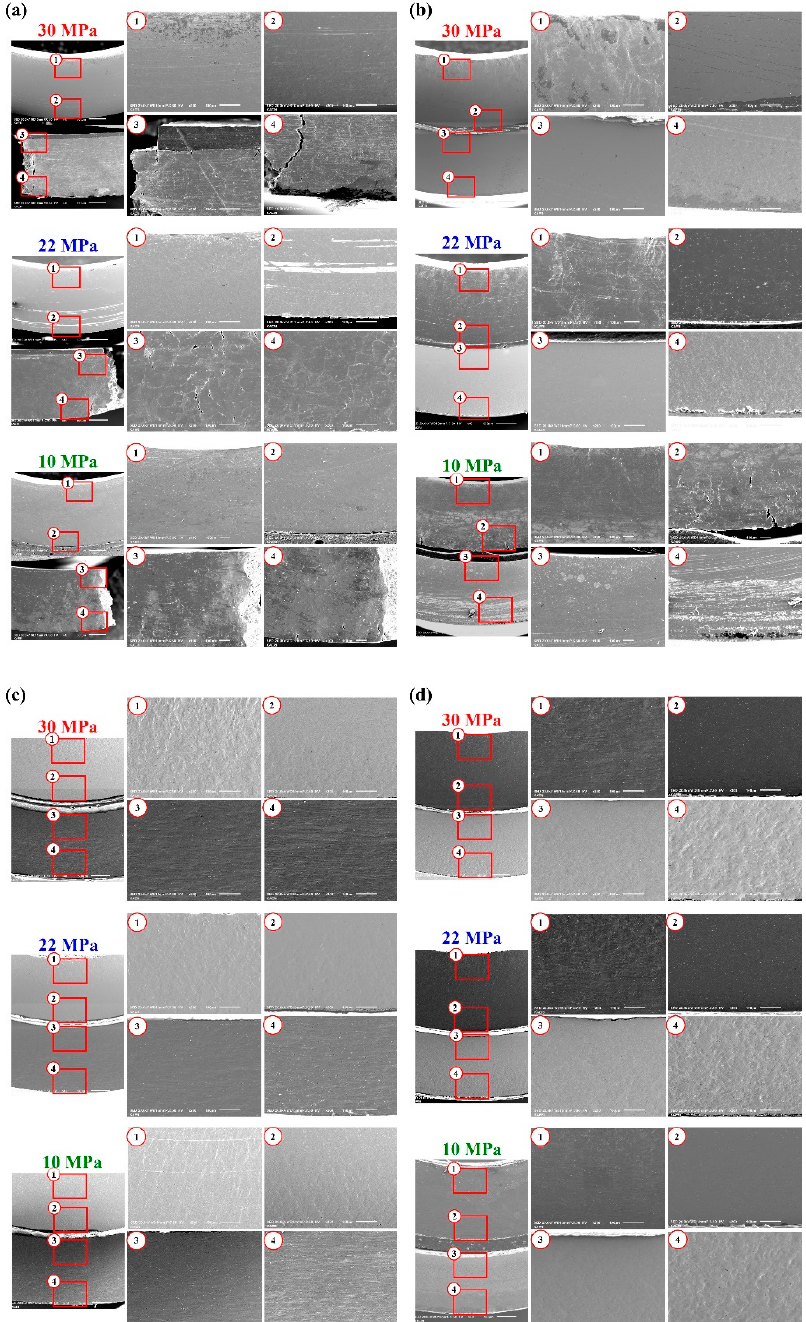
Figure 10. SEM images of the central areas in the multi-materials after the three-point bending test: ( a ) DP590 (upper)–A356 (lower), ( b ) DP590 (lower)–A356 (upper), ( c ) SS330 (upper)–A5052 (lower), and ( d ) SS330 (lower)–A5052 (upper).